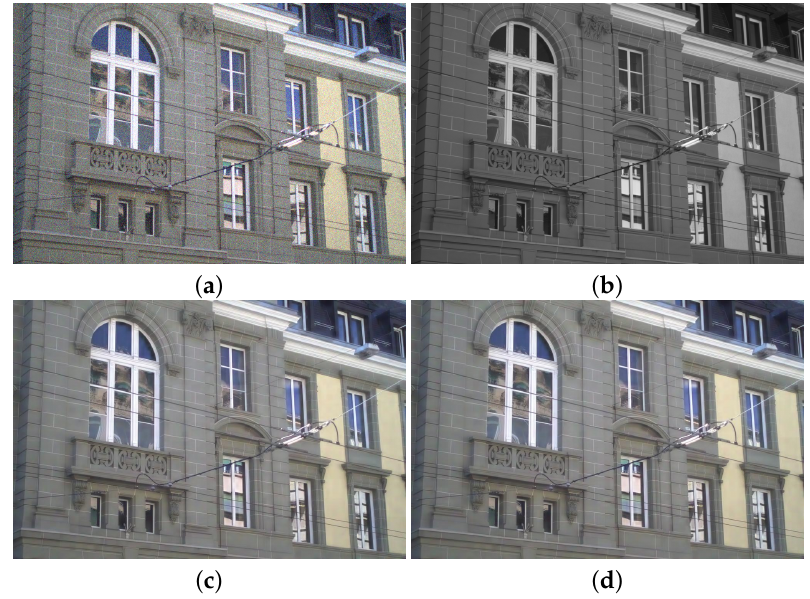
Figure 19. Experimental results from the proposed method in a local manner (the maximum decom- position level is 4). ( a ) RGB image; ( b ) NIR image; ( c ) Fusion result using a 64 × 64 local window; ( d ) Fusion result using a 128 × 128 local